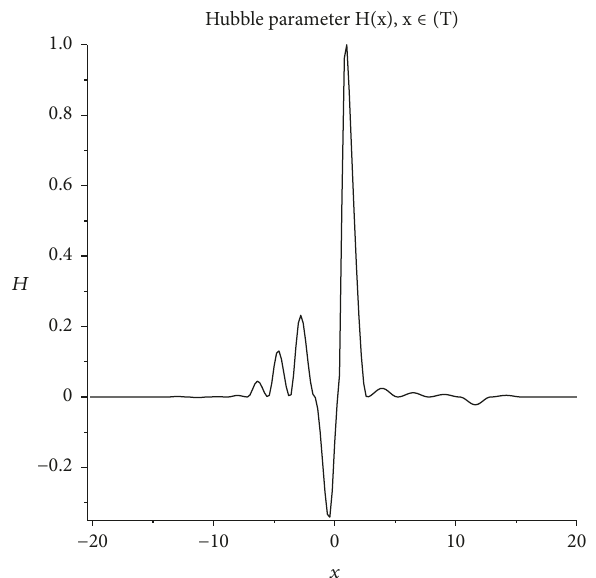
̇𝑏(𝑥)/𝑏(𝑥) ; 𝐻 𝑚 (1) = 1 is the current ̃𝐵 = 1.44517022939 , 𝑘 = 0 . 𝑛 2